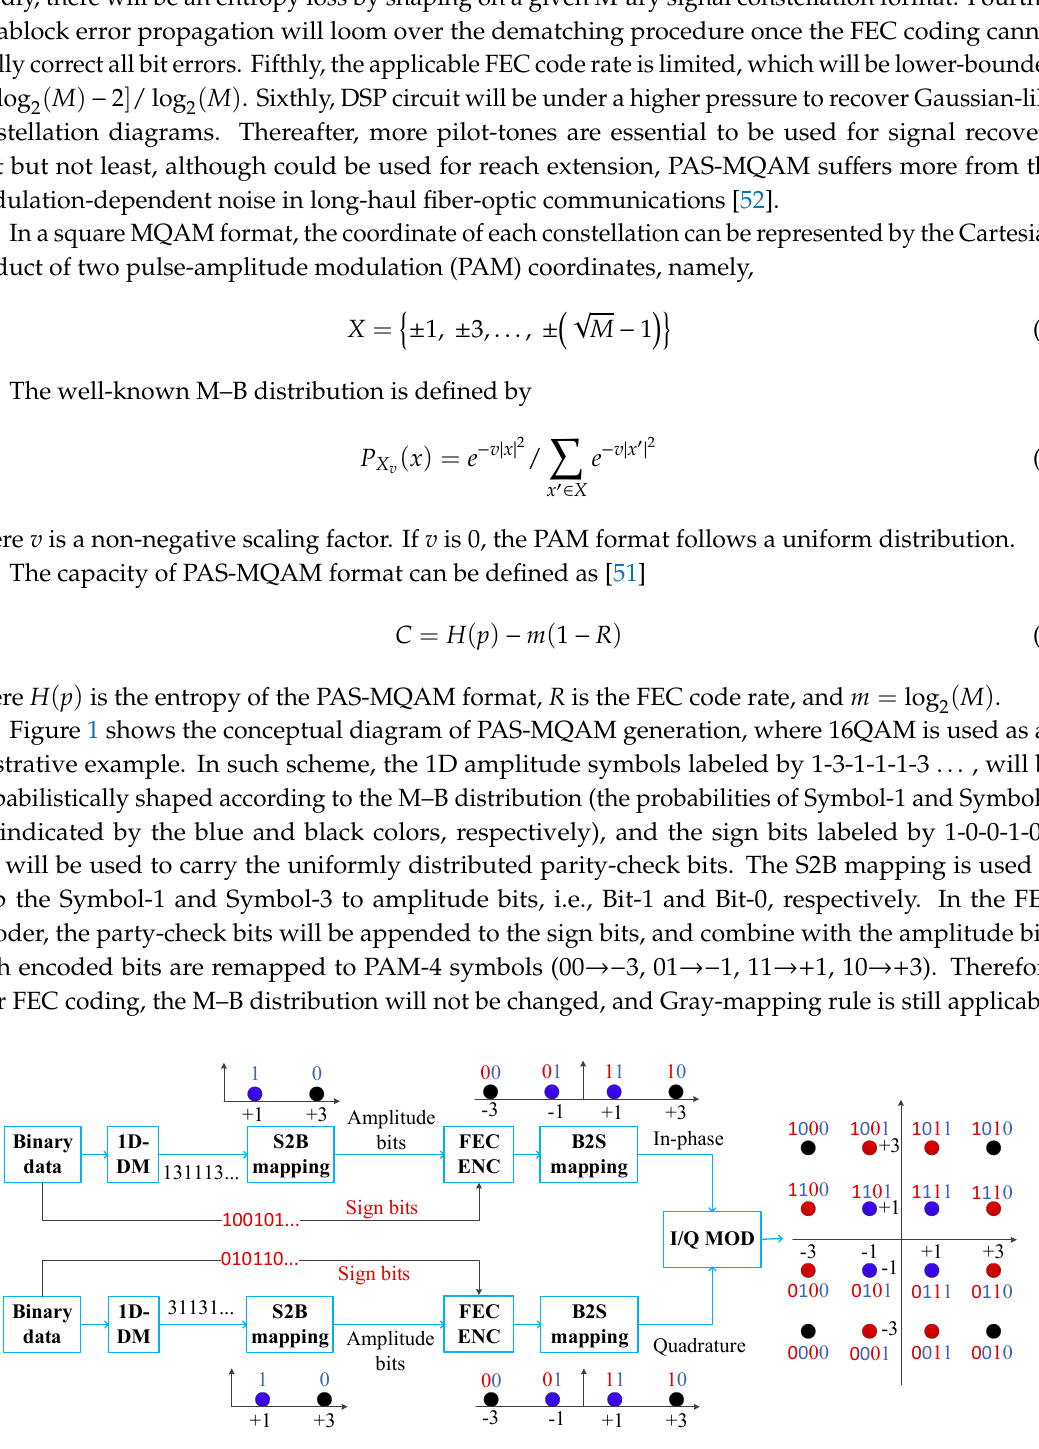
Figure1. Theconceptualdiagramofprobabilisticamplitudeshaping(PAS)-M-aryquadratureamplitude Figure 1. The conceptual diagram of probabilistic amplitude shaping (PAS)-M-ary quadrature modulation (MQAM) amplitude modulation (MQAM) generation.